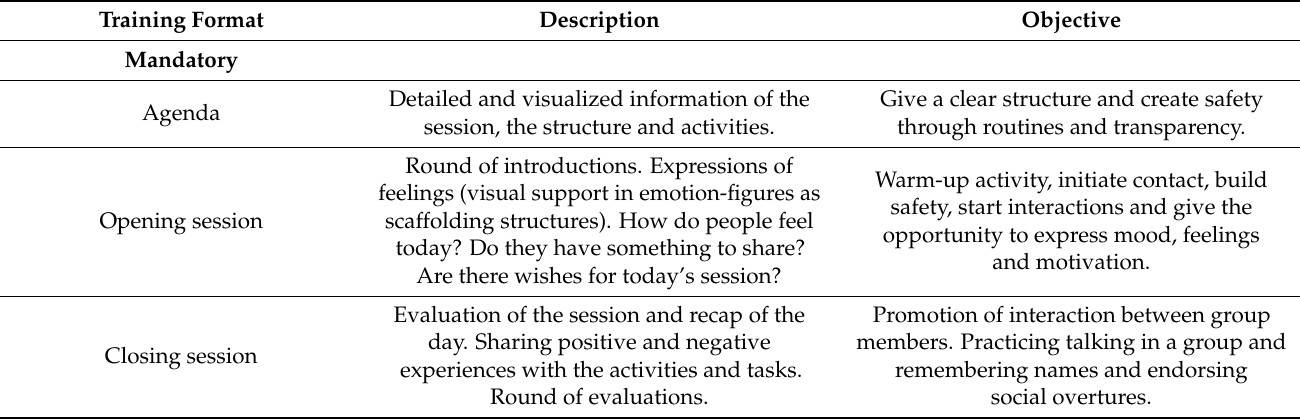
Table 2. Training formats in SKOLKONTAKT ®